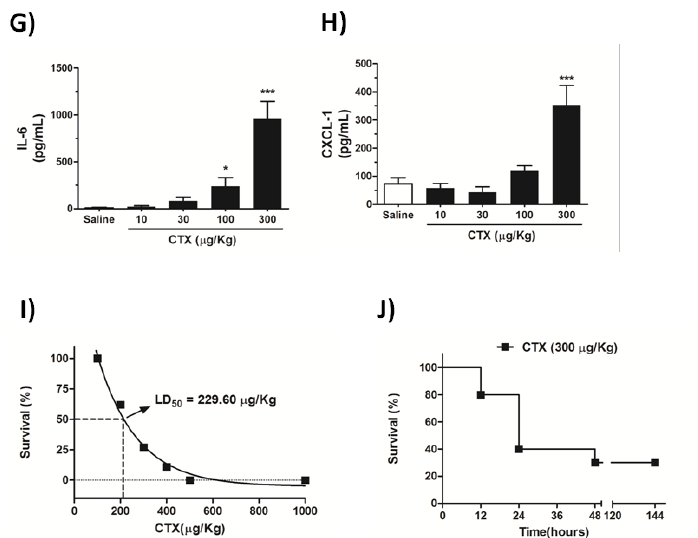
Figure 1. Dose-response toxicological e ff ects of CTX. Mice were treated with di ff erent CTX doses (10–300 µ g / Kg s.c.) and the biological parameters were evaluated at 6 h. ( A ) Open field test. ( B ) Hematocrit. ( C ) Serum creatine kinase (CK). ( D ) Serum creatine kinase-MB (CK-MB). ( E ) Serum aspartate aminotransferase (AST). ( F ) Total and di ff erential leukocyte counting in dorsal air pouch fluid. ( G ) IL-6 levels in dorsal air pouch fluid. ( H ) CXCL-1 levels in dorsal air pouch fluid. ( I ) Determination of LD 50 . ( J ) Time-course survival profile. The results are representative from two-independent experiments ( n = 6–7). # p < 0.05, $ p < 0.05, * p < 0.05, ** p < 0.01, *** p < 0.001 compared with animals treated with saline (control)—One-way ANOVA followed by Tukey’s multiple comparison test